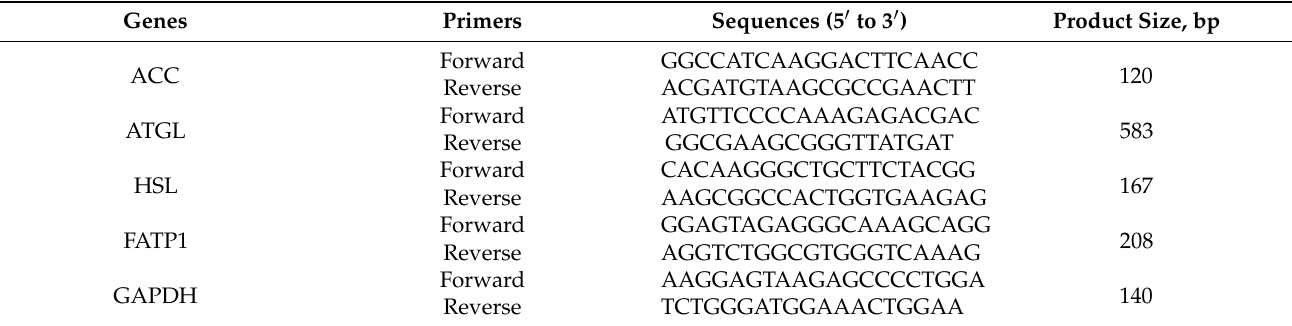
Table 3. Primers used for quantitative real-time PCR.